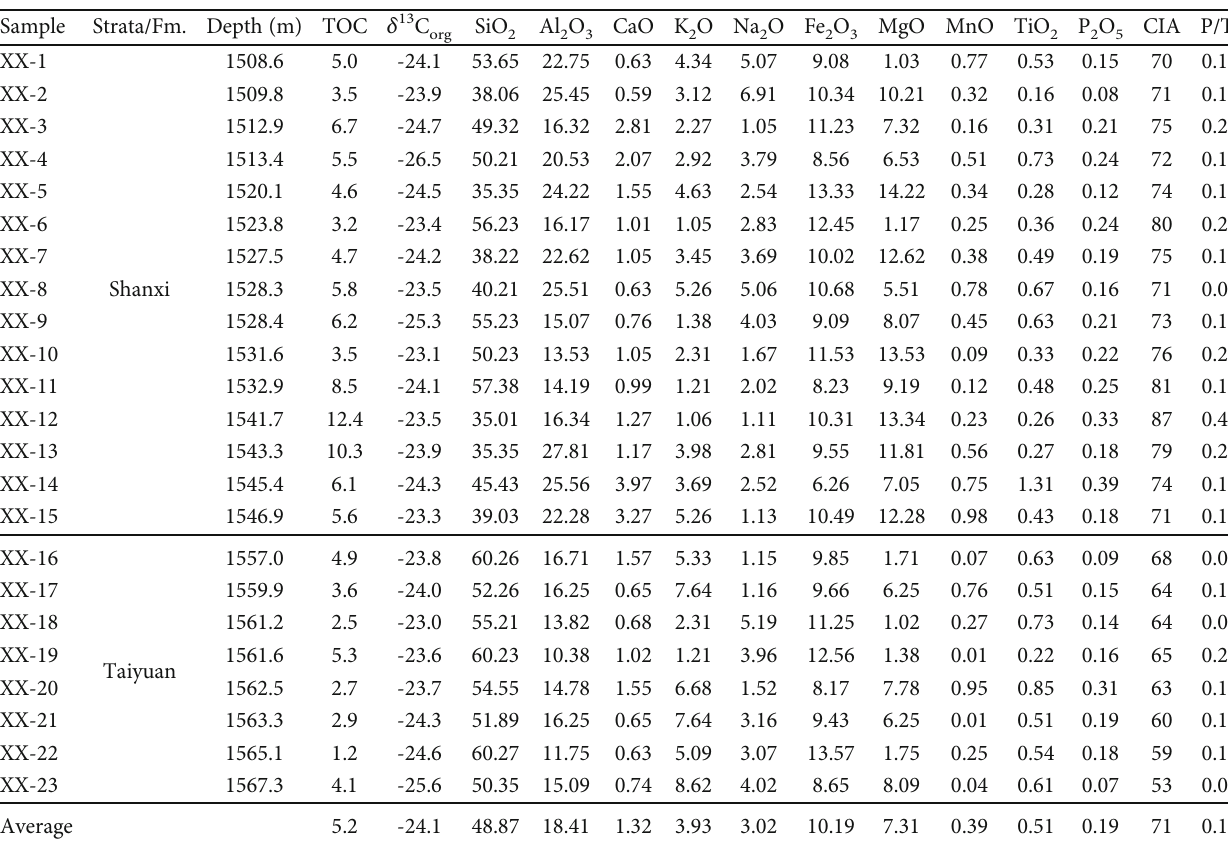
, major elements and the calculated element ratios, and CIA of org